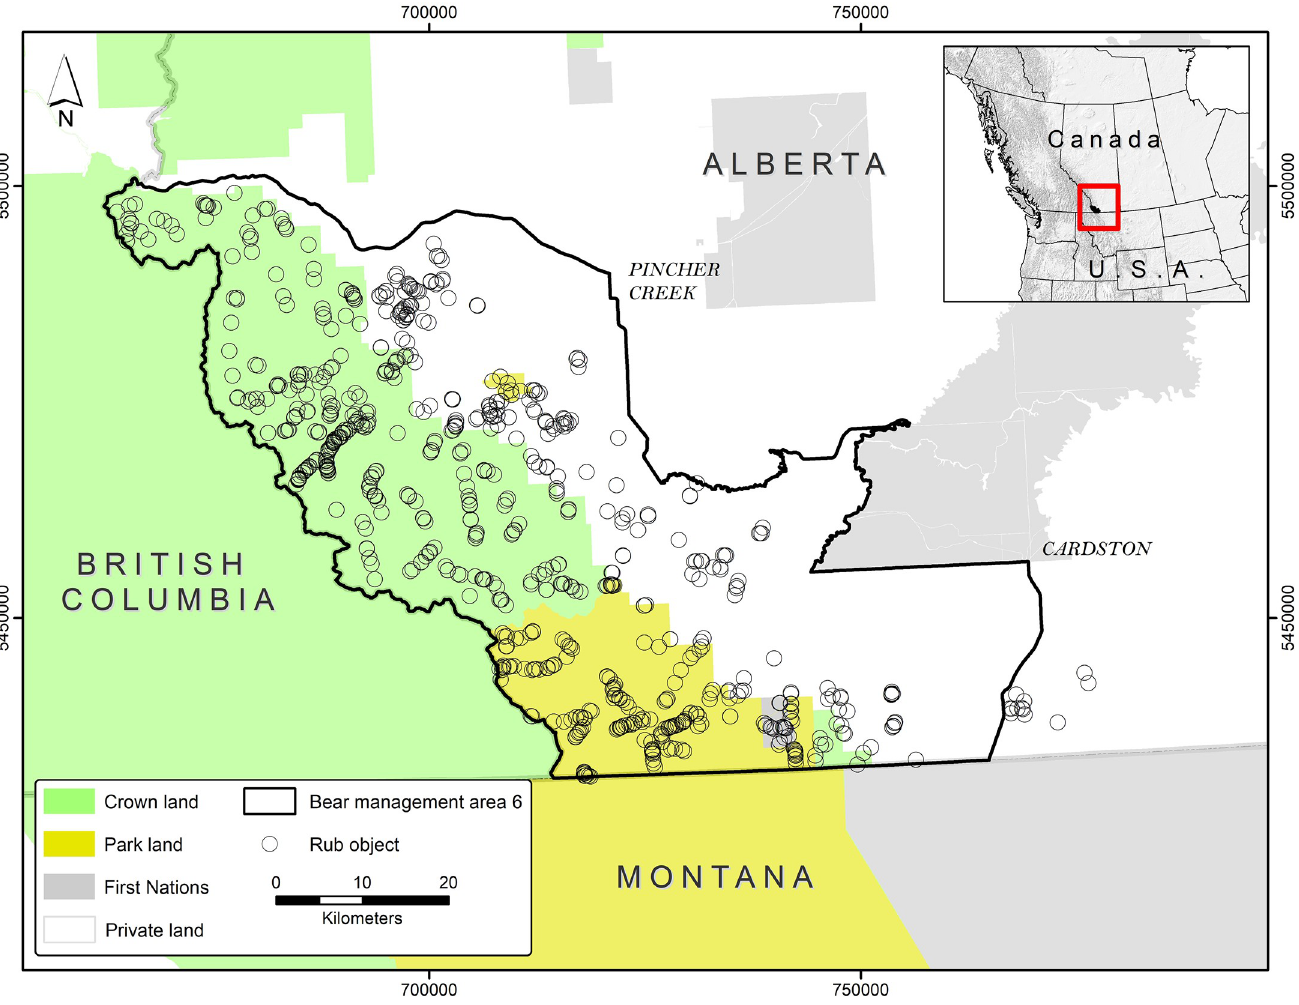
Fig 1. Study area. Map of the study area in southwestern Alberta,